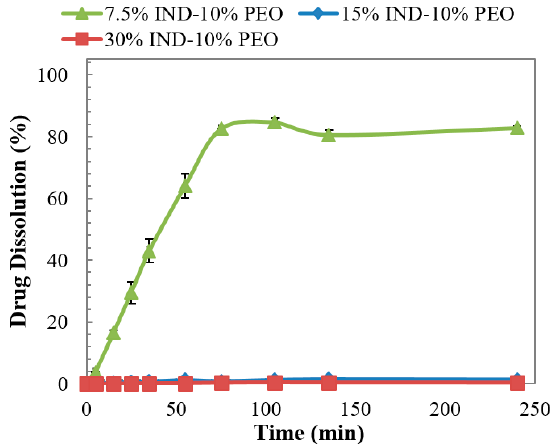
Figure 9. Dissolution of injection moulded tablets of PVPVA-PEO-IND solid dispersions in pH 1.2 dissolution medium.